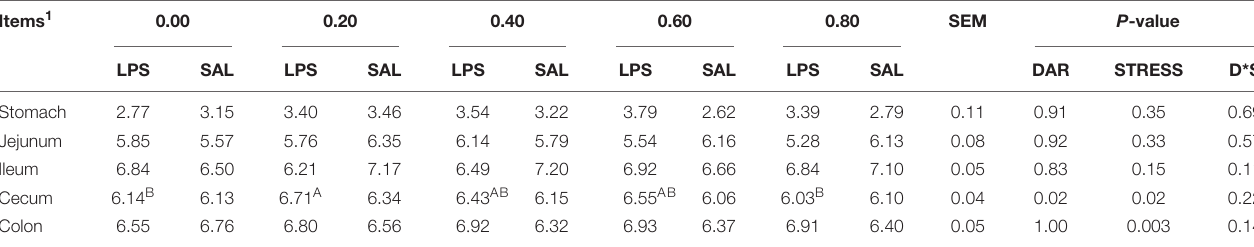
TABLE 4 | Effect of DAR on the pH value of the digesta of weaned piglets challenged with E. coli LPS. Items